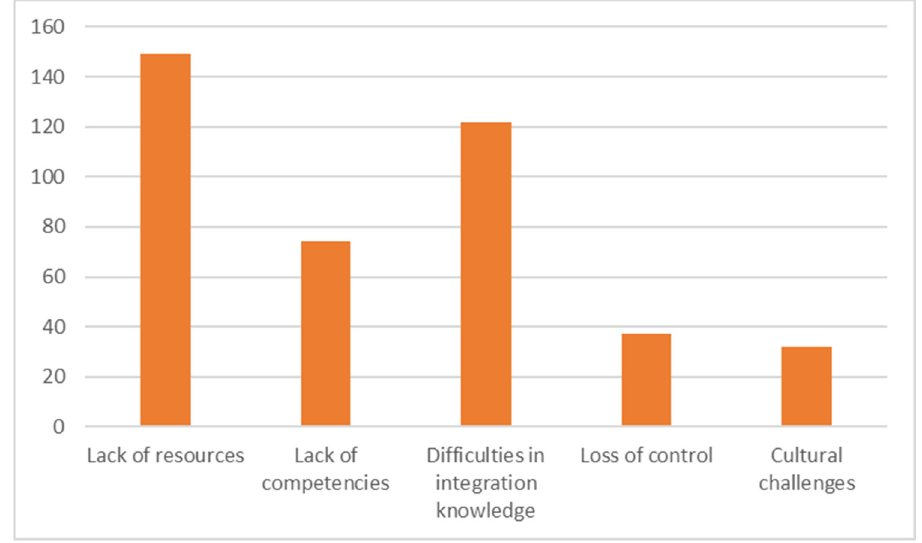
Figure 3. Challenges of open innovation for Portuguese SMEs.